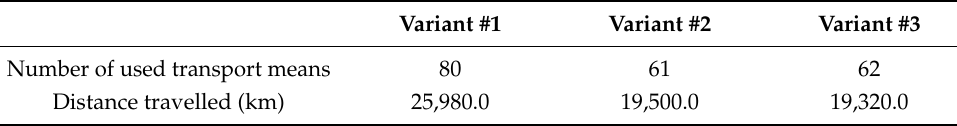
Table 16. Number transport means used and distance travelled (MS